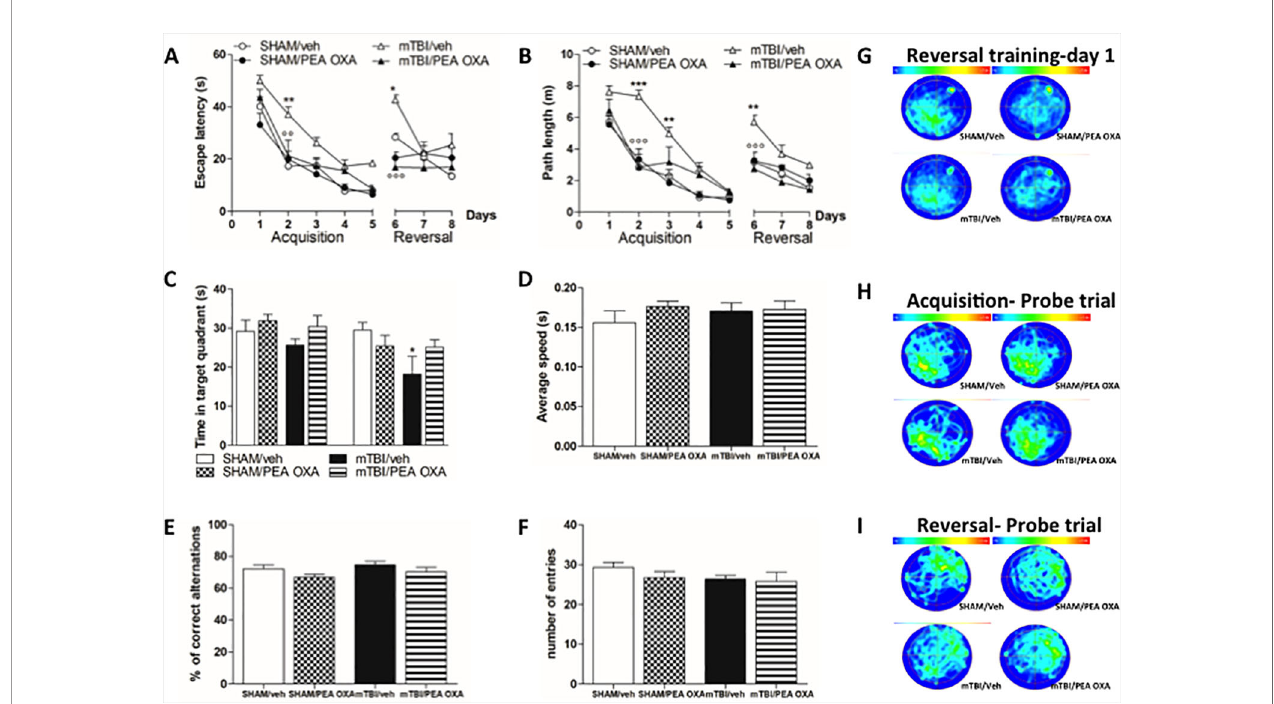
FIGURE 4 | Effects of repeated administration of vehicle (Kolliphor 5%) or PEA-OXA (10 mg/kg, i.p.) on spatial and working memory in sham and mTBI mice. (A , B) Escape latency and path length, respectively, across 9 days of MWM reference platform task, (C , D) Time spent in the target quadrant and average speed, respectively, during probe tests of MWM test, (E , F) % of correct alternations and number of entries, respectively, in Y-maze test, (G – I) Occupancy plots during repeated MWM training and probe tests. Data are represented as mean ± SEM of eight mice per group. *P < 0.05, **P < 0.01, and ***P < 0.001 indicate signi fi cant differences compared to SHAM/veh. °P < 0.05, °°P < 0.01, and °°°P < 0.001 indicate signi fi cant differences compared to TBI/veh. P < 0.05 was considered statistically signi fi cant. One-way or Two-way ANOVA, followed by Bonferroni post hoc test was